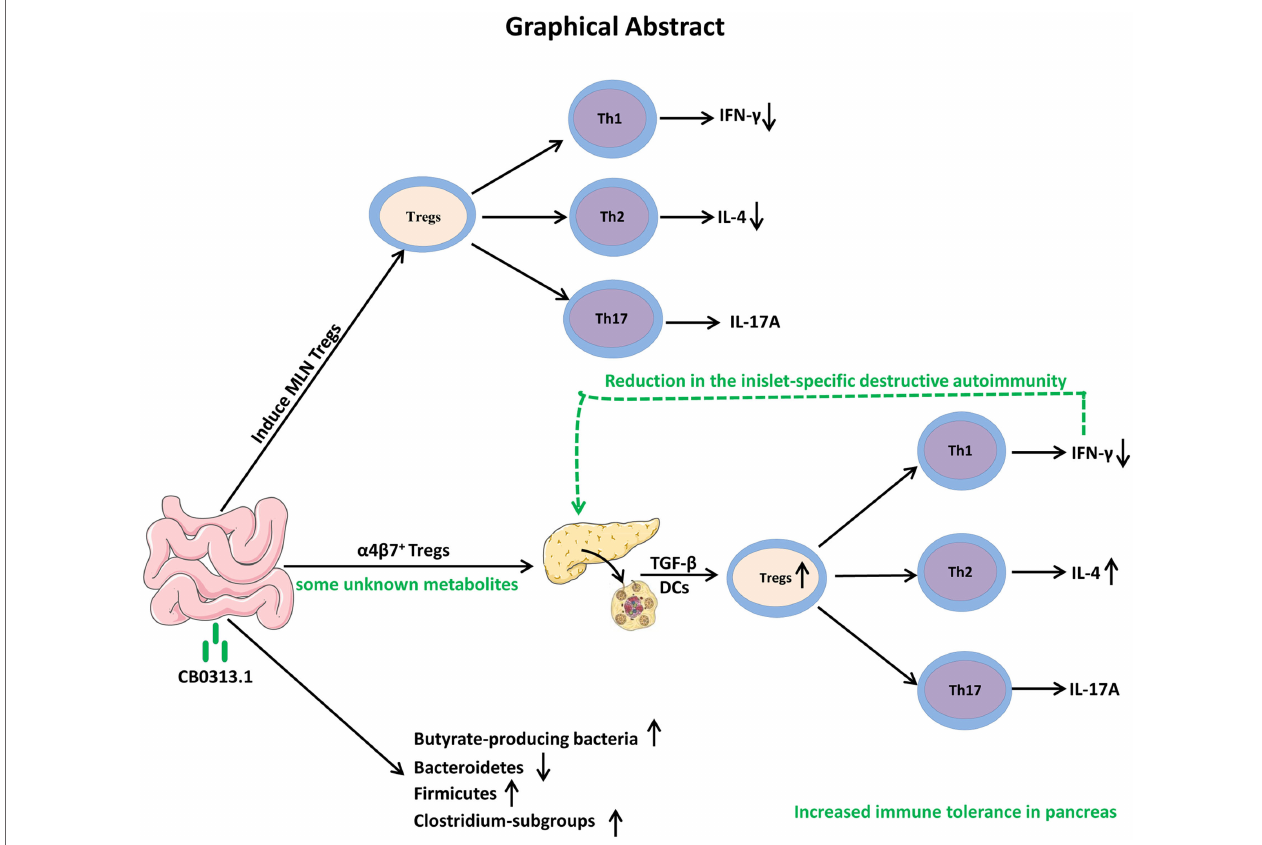
FigUre 10 | Graphical abstract. Early oral CB0313.1 administration (starting at weaning in diabetes-prone NOD mice) induced Tregs in PLN and pancreas, balanced pancreatic Th1/Th2/Th17 cells, enhanced Firmicutes/Bacteroidetes, enriched Clostridium -subgroups and butyrate-producing bacteria subgroups, eventually preventing the onset and progression of type 1